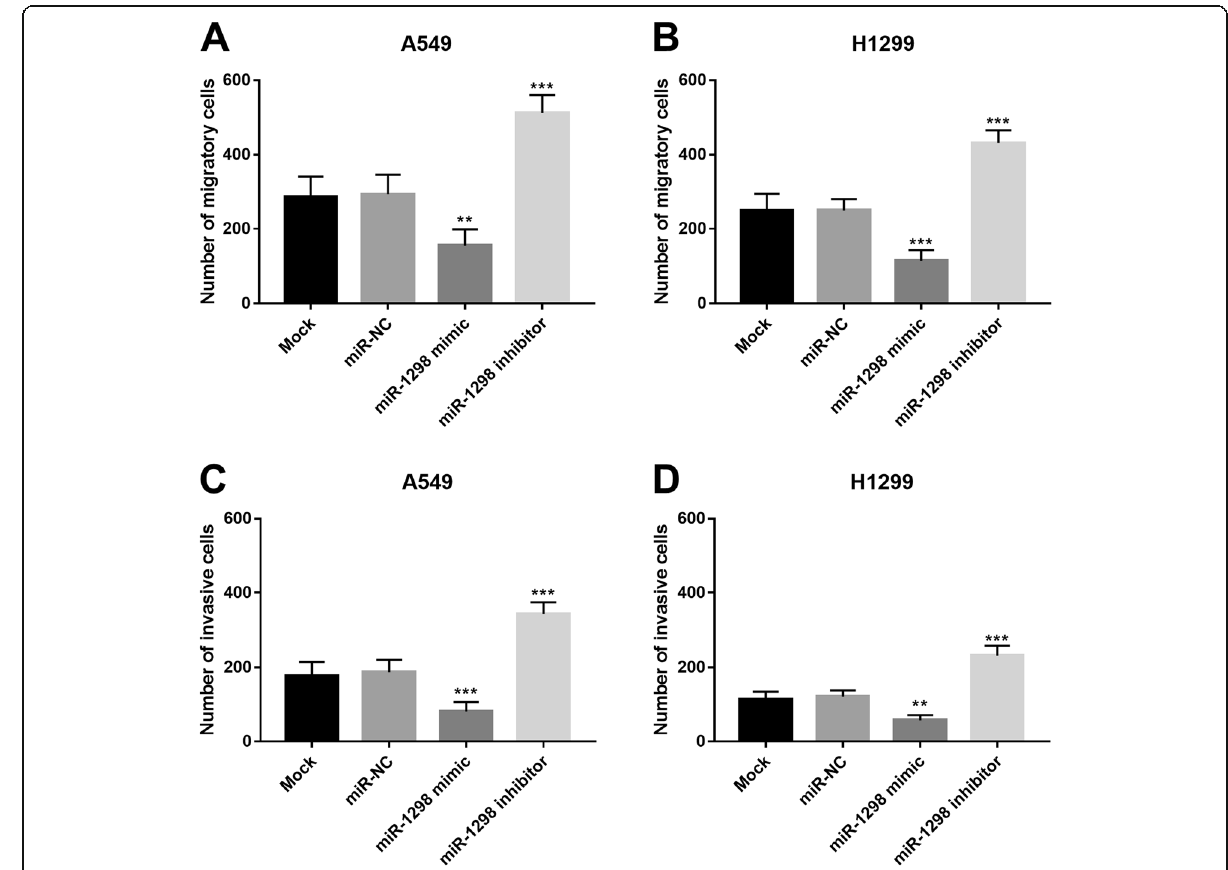
Fig. 4 Effects of miR-1298 on NSCLC cell migration and invasion in A549 and H1299 cell lines. A and B. The overexpression of miR-1298 inhibited tumor cell migration, but the reduction of miR-1298 promoted tumor cell migration. C and D. Tumor cell invasion was facilitated by the knockdown of miR-1298, whereas was suppressed by the overexpression of miR-1298. ** P < 0.01 *** P <